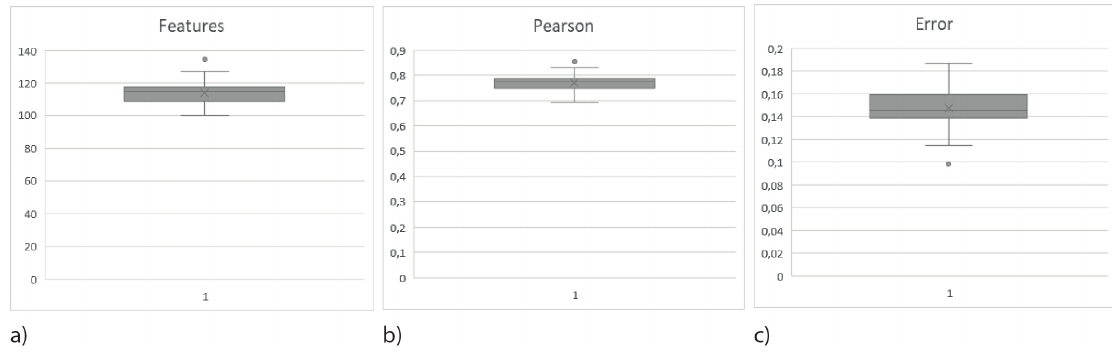
Figure 2. Results obtained in the experiments carried out with CGS. ( a ) Features used in each of the 50 runs. ( b ) Pearson correlation of the validation set in each run. ( c ) Average error obtained in each